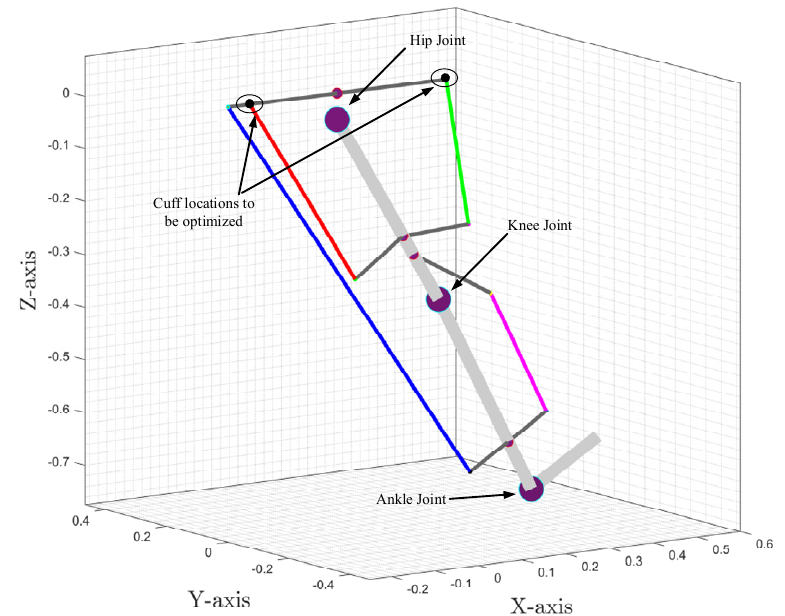
Figure 6. The exoskeleton and 3D space for optimal cuff location.